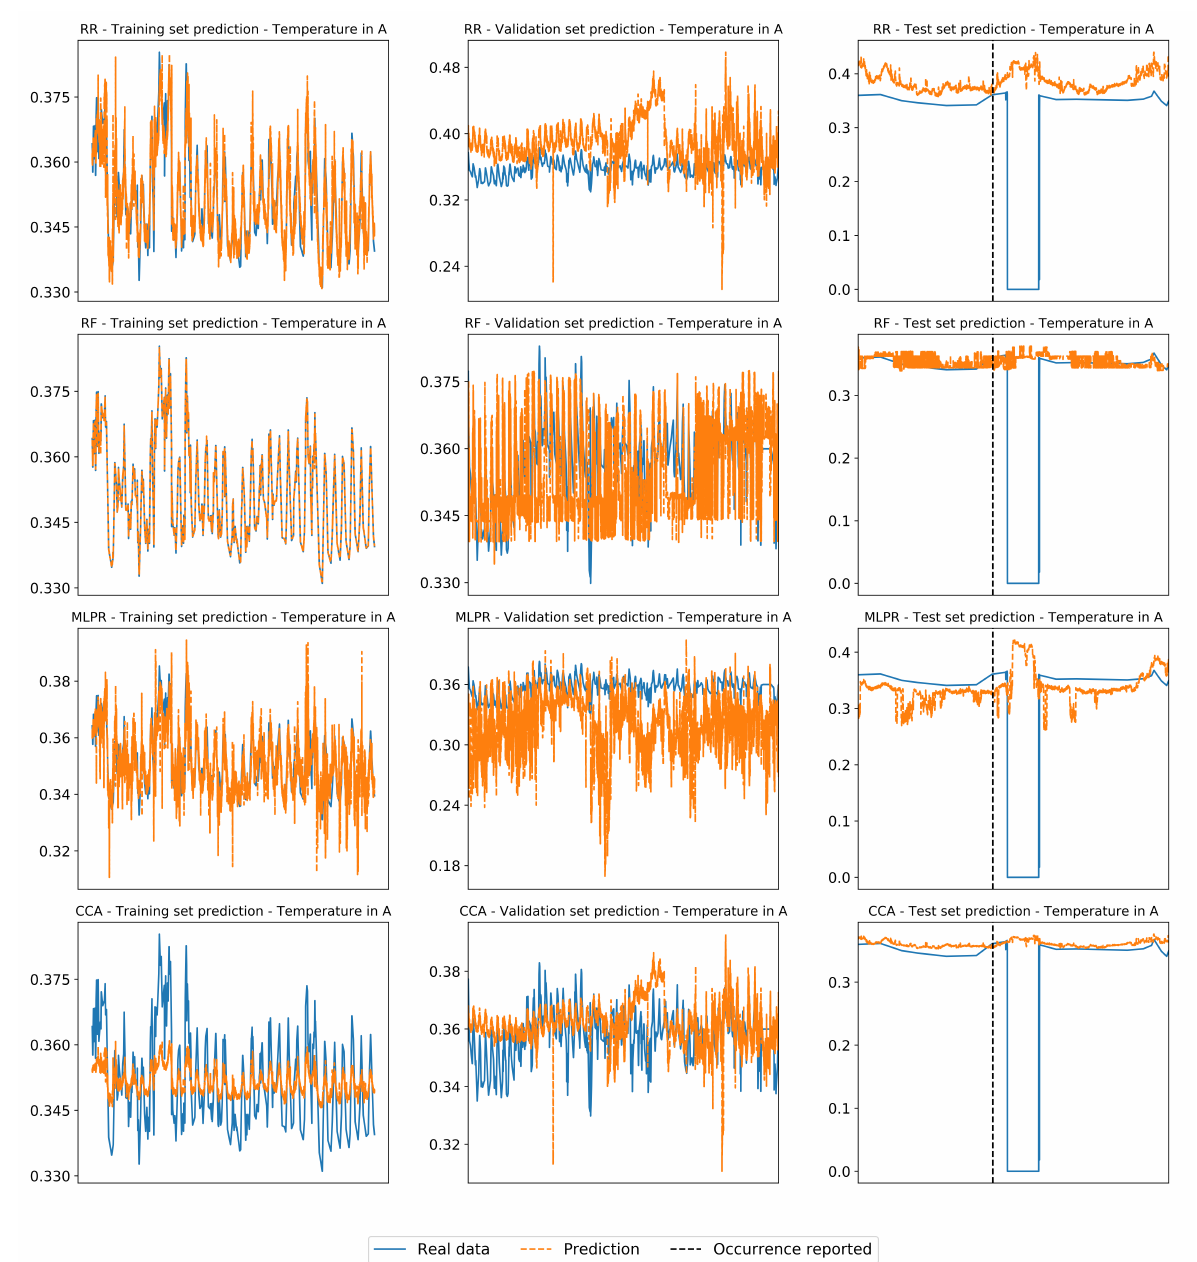
Figure A8. Regressors prediction for dimensionless temperature in fiscal meter 02A (Section A) along Fault-FIII without considering variable selection